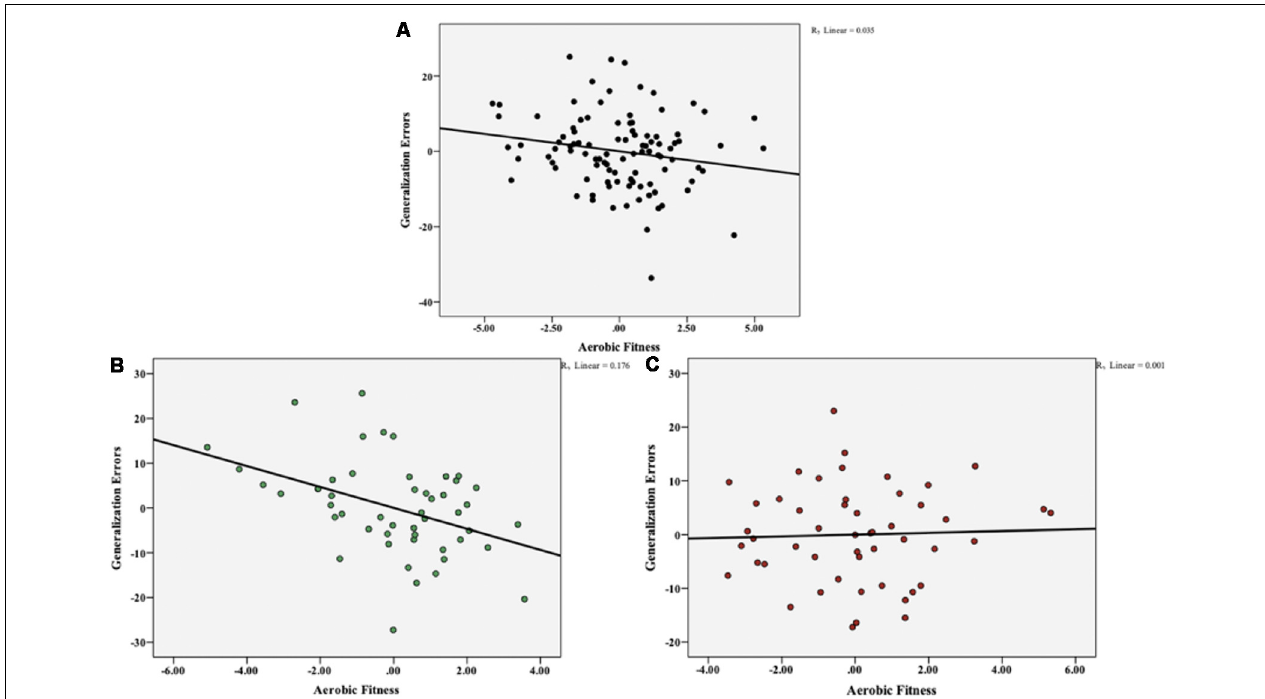
FIGURE 4 | Overall aerobic fitness (VO 2 max) was negatively correlated with total generalization errors, but this relationship did not reach significance (p = 0.071) (A) . At the individual group level, there was a significant negative correlation between VO 2 max and generalization errors for the non-risk group (p = 0.004) (B) , but not for the risk group (p = 0.809) (C) .